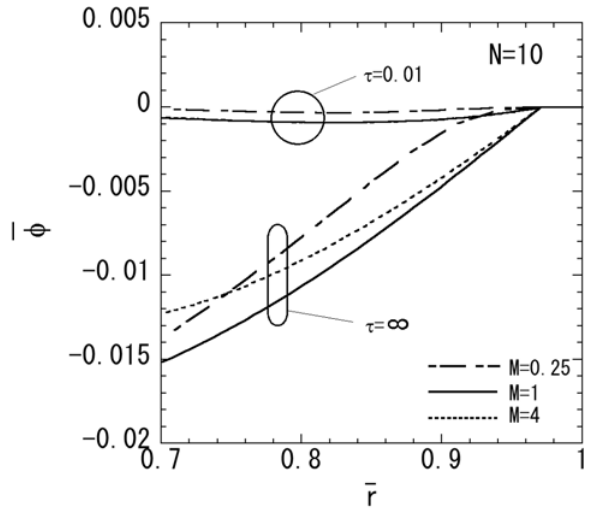
Figure 7. Variation of the electric potential ( 10 = N